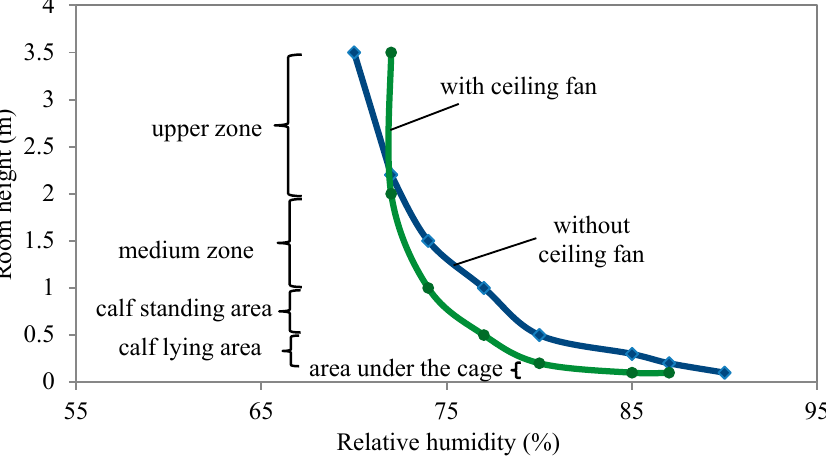
Figure 6. ARH distribution, in preventive maintenance premises for calves.